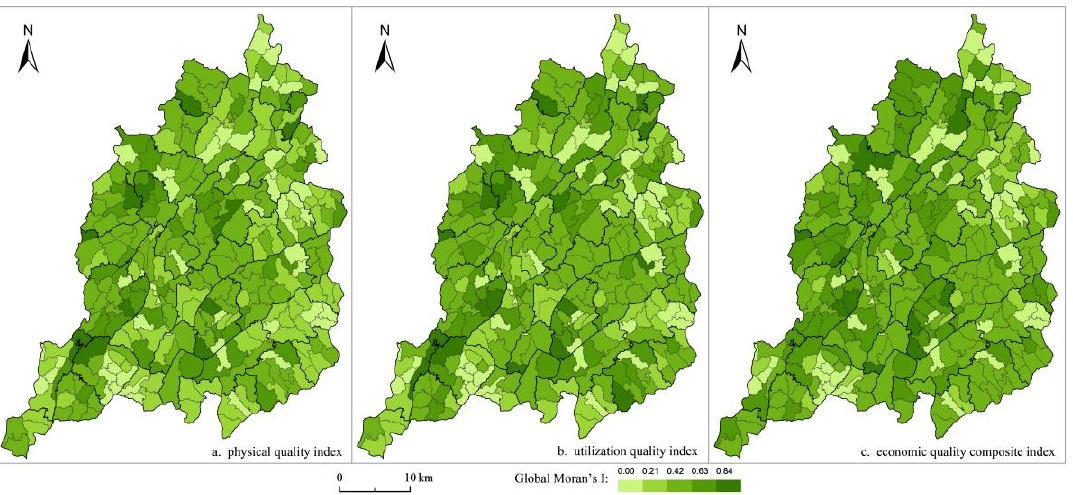
Figure 4. Spatial distribution of global Moran’s I value of cultivated land quality index at village scale of study area.